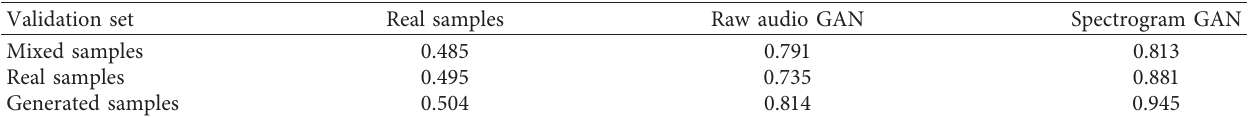
Figure 8: Qualitative evaluation of the GAN model with (a) raw audio and (b) spectrograms. Table 5: Quantitative evaluation